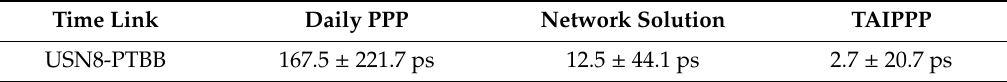
Table 3. Statistics of the day boundary discontinuities for PPP and Network